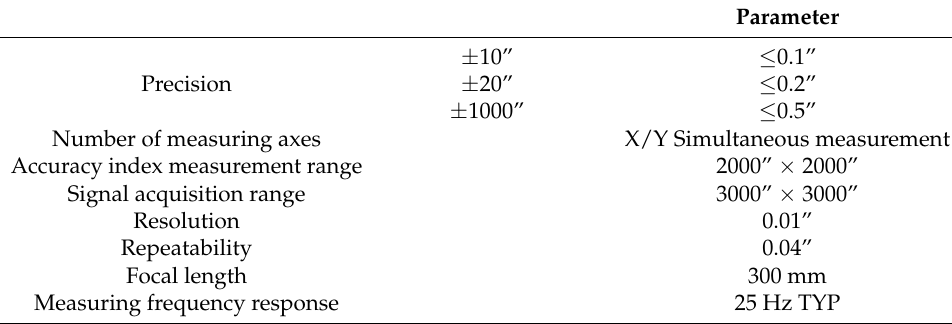
Table 2. Main technical parameters of the dual-axis photoelectric autocollimator.